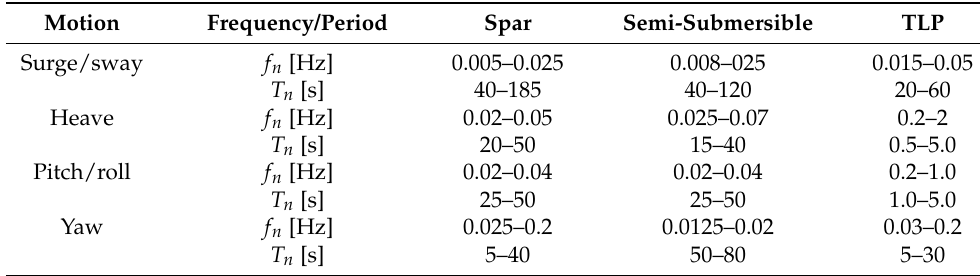
Table 2. Indicative natural frequencies (Hz) and natural periods (s) of ‘rigid-body motion modes’ of floating offshore wind turbines. Adapted ‘Table 2’ of